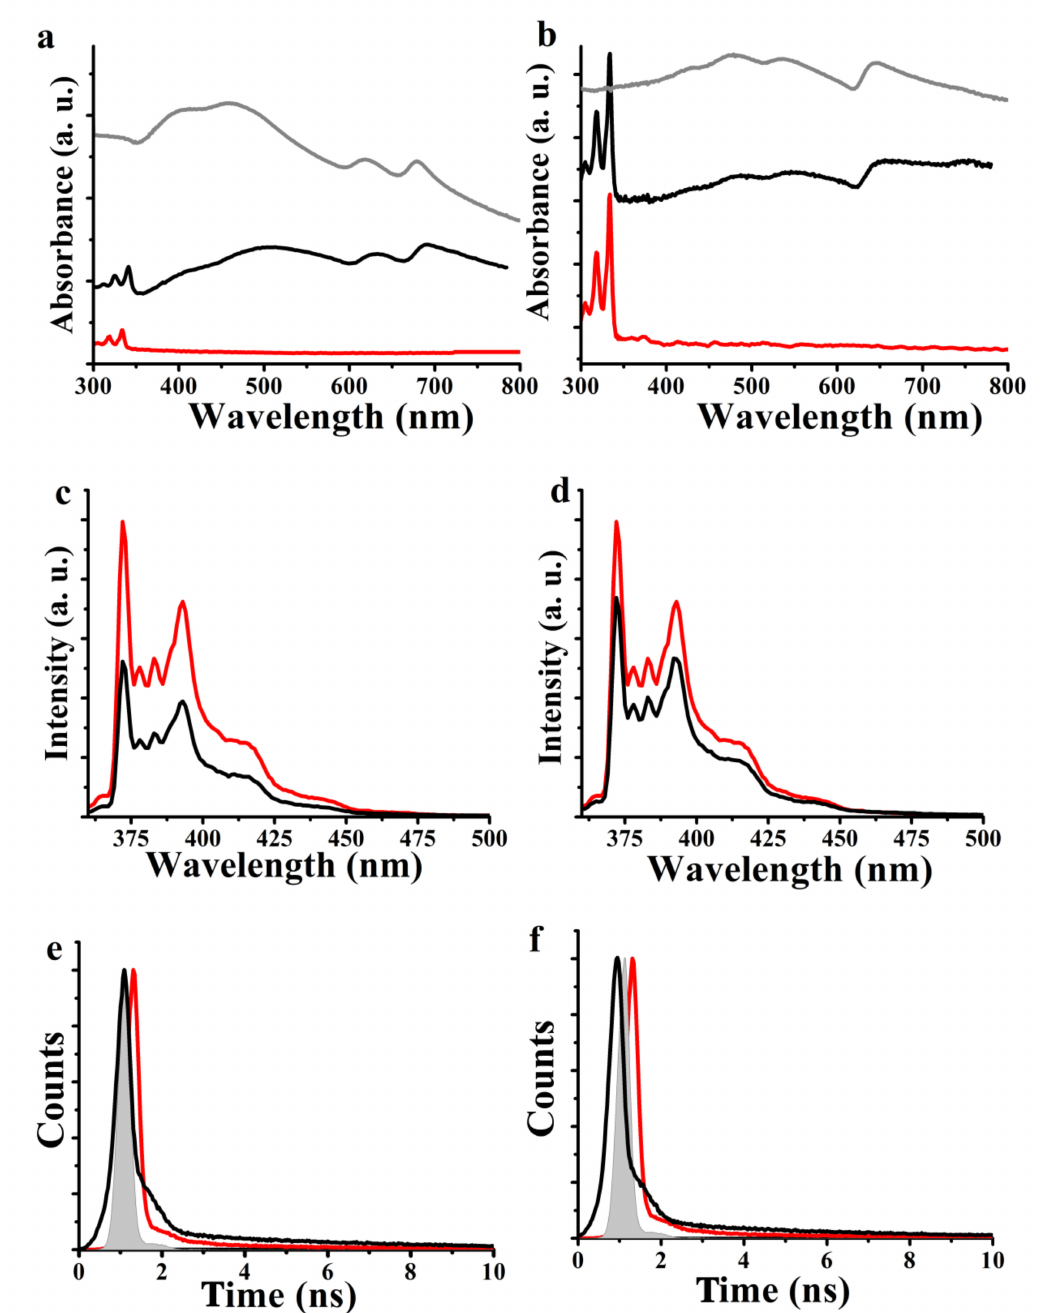
Figure 1. ( a , b ) UV-Vis spectra for free pyrene (red) as compared with ( a ) nanoensemble 1a (black line) and exfoliated MoS 2 (gray line), and ( b ) nanoensemble 1b (black line) and exfoliated WS 2 (gray line), obtained in DMF. ( c , d ) Photoluminescence spectra for free pyrene (red line) as compared with nanoensemble ( c ) 1a (black line), and ( d ) 1b (black line), obtained in DMF upon excitation at 340 nm. ( e , f ) Photoluminescence decay time profiles for free pyrene (red) and nanoensemble ( e ) 1a (black line), and ( f ) 1b (black